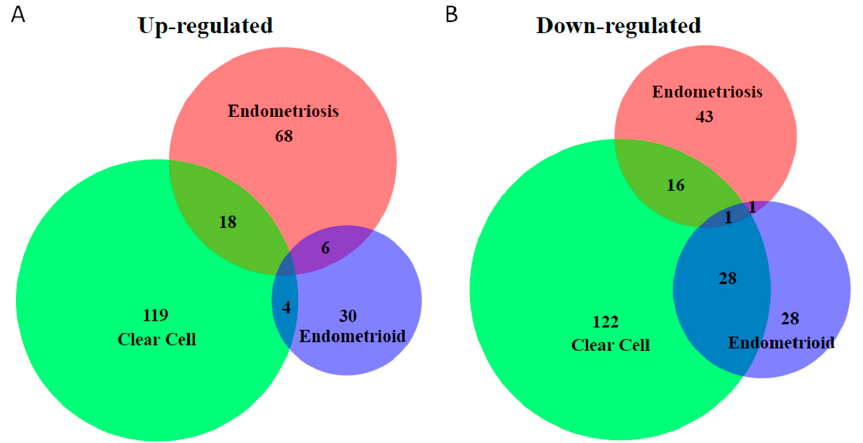
Figure 2. Venn diagram of overlap of number of miRNAs differentially expressed in endometriosis and ovarian clear-cell and endometrioid adenocarcinoma. The miRNAs differentially expressed are depicted in three overlapping circles. The numbers indicate the miRNA counts that are unique or in common between the groups. ( A ) Upregulated miRNAs; ( B ) downregulated miRNAs. Supplemental Table S1 details the miRNAs in each group above.